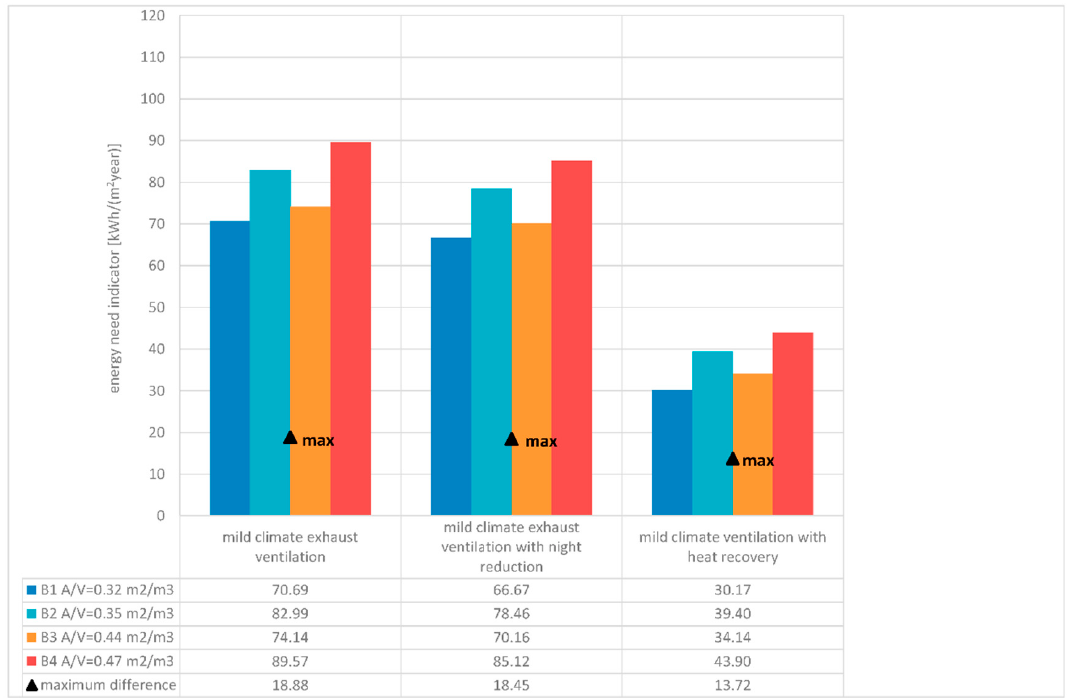
Figure 6. The impact of the building shape factor on the energy need indicator.